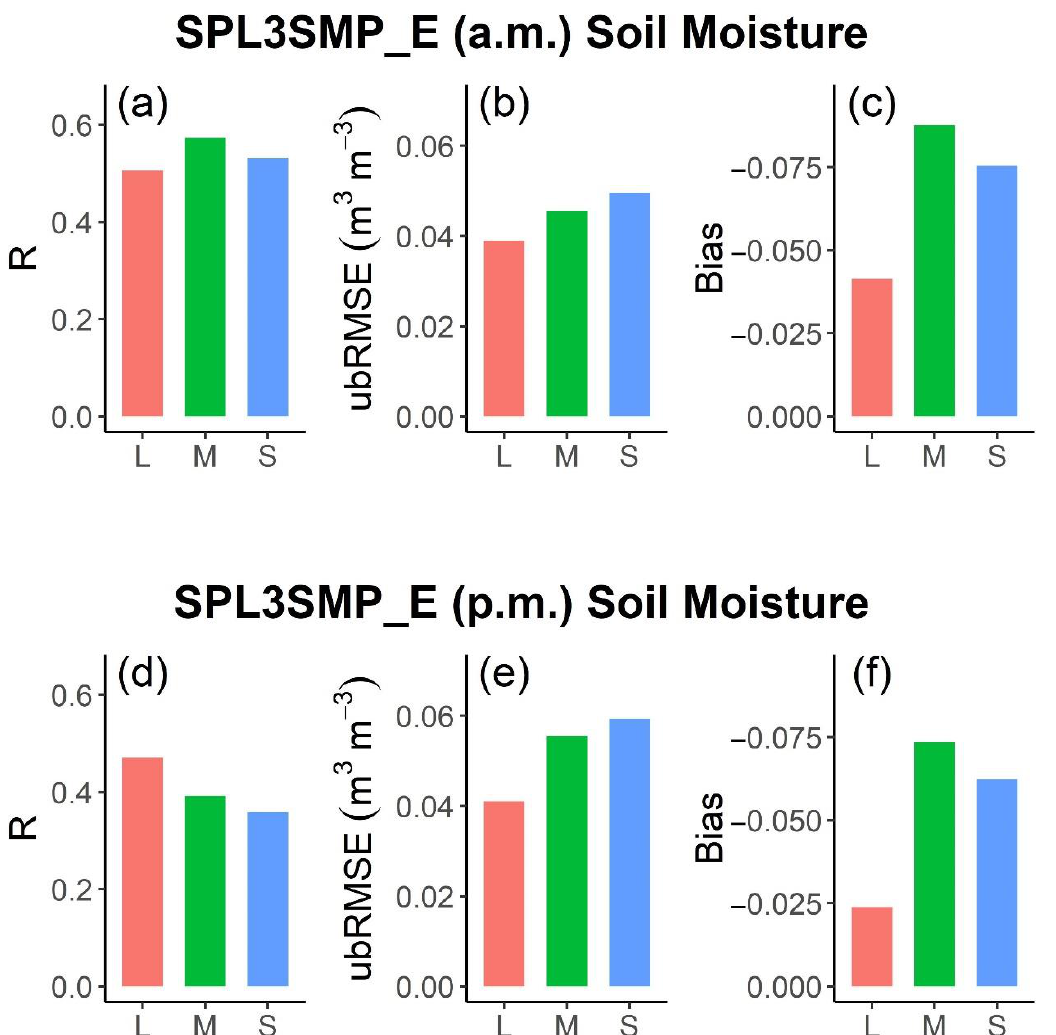
Figure 8. Performance metrics (R ( a , d ), ubRMSE ( b , e ), bias ( d , f )) for SPL3SMP_E a.m. (top row) and (bottom row) p.m. SM estimates at S-scale, M-scale, and L-scale sites.